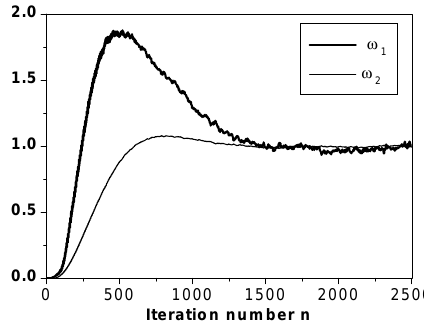
Fig. 18. Evolution of the normalized filter coefficients ( LMS ), case ( C 4 ).